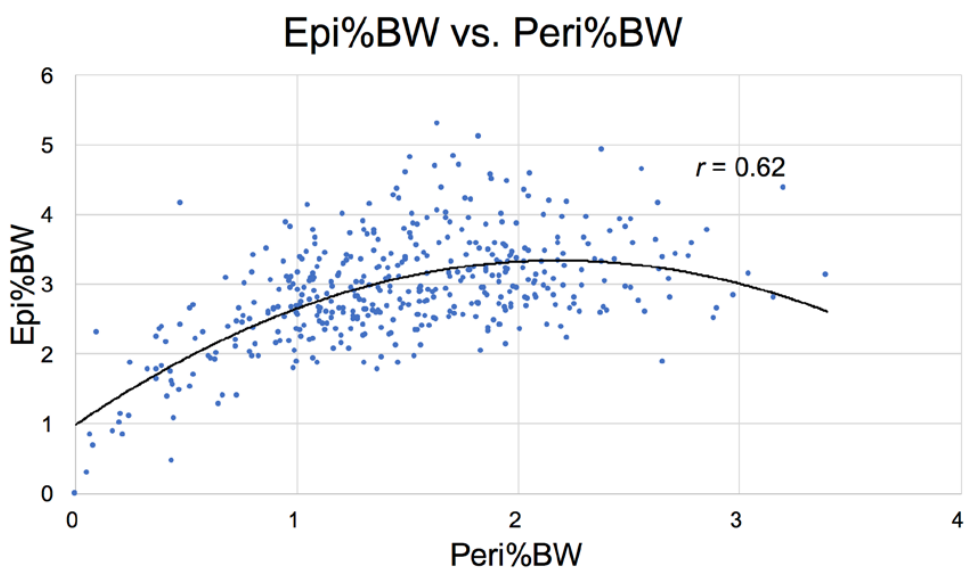
Figure 14. Correlation between Epi and the Peri fat pads as %BW is strong, but less robust than that between Peri%BW vs. BAT%BW (see Figure 12) ( n = 439). This suggests that Peri and BAT are in close sync and that, though large, the Epi fat pools of Nile rat start losing their adipose storage role as diabetes progresses and may not be as involved in acute metabolic events as Peri and